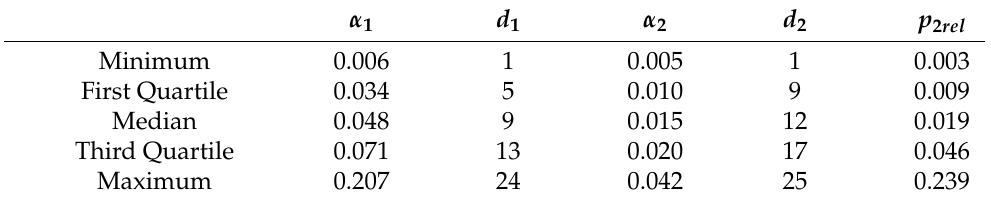
Figure 1. Examples of time series analyses performed on the temporal incidence of SARS-CoV-2 infections (grey area, left scale) and the incidence of COVID-19 associated deaths (red line, right scale). The three-phase-prediction model (black line, right scale) for COVID-19 associated deaths based on actual incidences has been estimated for each country. The second phase of the model with a constant number of deaths is identifiable by the horizontal black line. ( a ) Greece (cluster 1), exhibits a constant increase of incidences over time ( α 1 = 4.7% and α 2 = 4.2%). ( b ) For Germany ( α 1 = 4.5% and α 2 = 1.5%—cluster 2), and ( c ) the Netherlands ( α 1 = 13.1% and α 2 = 0.8%—cluster 3), the threshold effect is particularly visible: the case fatality rates did not increase during the summer months, despite a relevant increase of COVID-19 incidences. Table 2. The 5-point summary statistics of the five model parameters estimated for 32 European